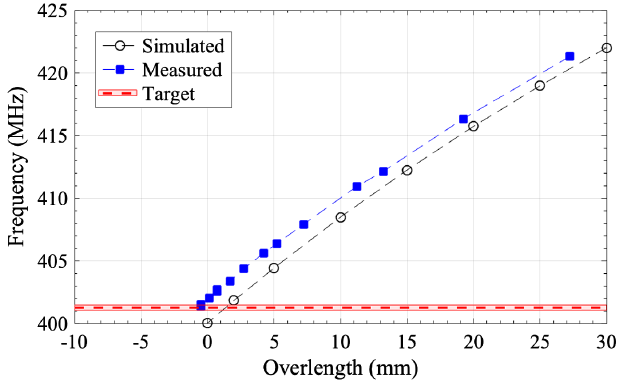
FIG. 7. Frequency evolution during trim tuning of cavity 1. Each data point (blue square) corresponds to the frequency measured at a certain trimming stage. The dashed red line represents the target frequency for the clamped assembly, 401.25 MHz, while the red shadowed area represents the frequency tolerance, (cid:2) 0 . 20 MHz. In black, the frequency response to trim tuning from CST